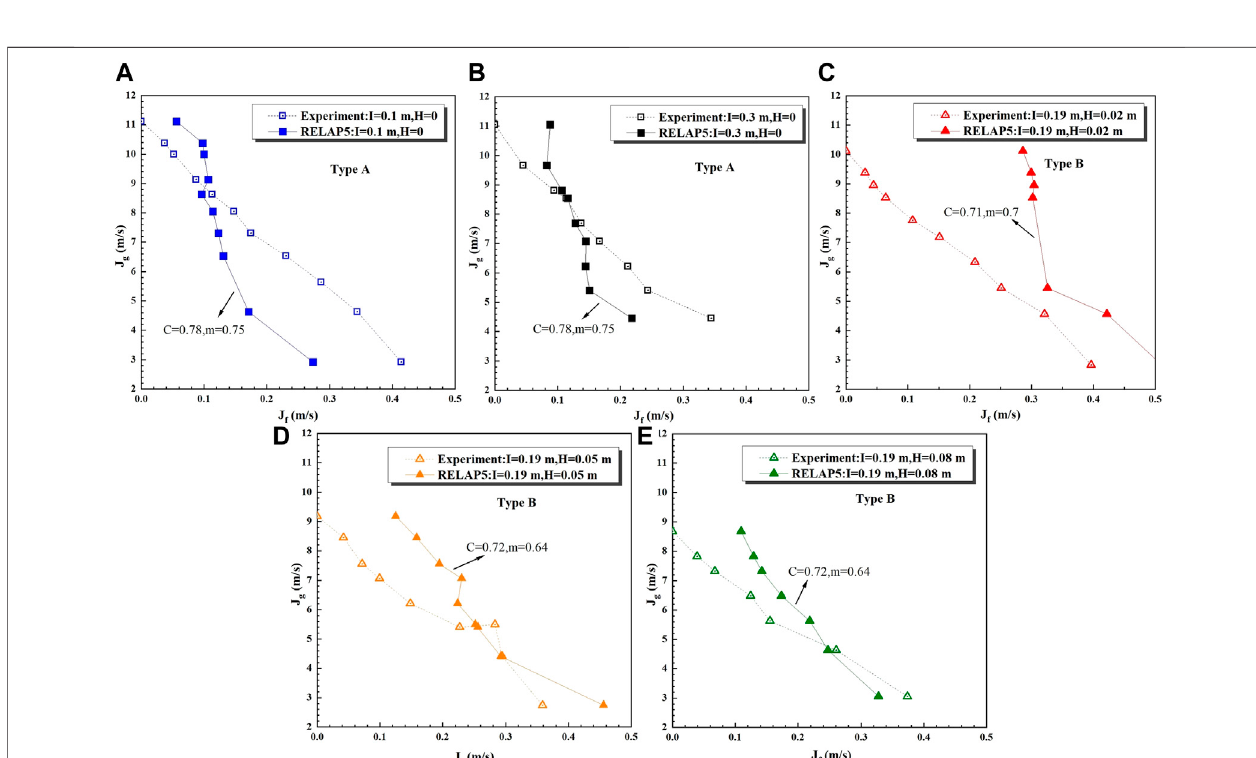
FIGURE 10 | Effect of length of horizontal